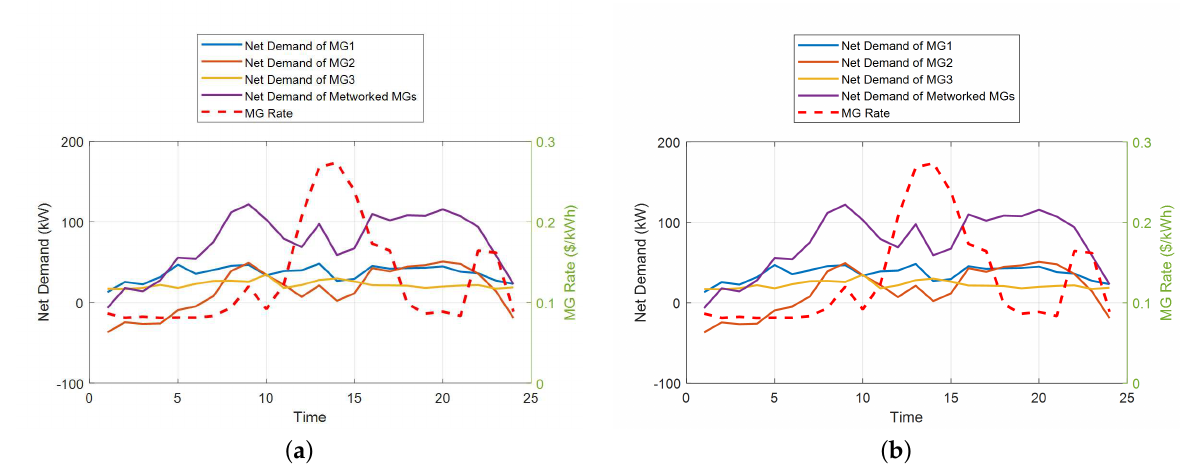
Figure 9. Converged price signal and net demand of networked microgrids by different distributed methods in grid-connected mode. ( a ) ADMM-based distributed optimization. ( b ) MILP-based dis- tributed